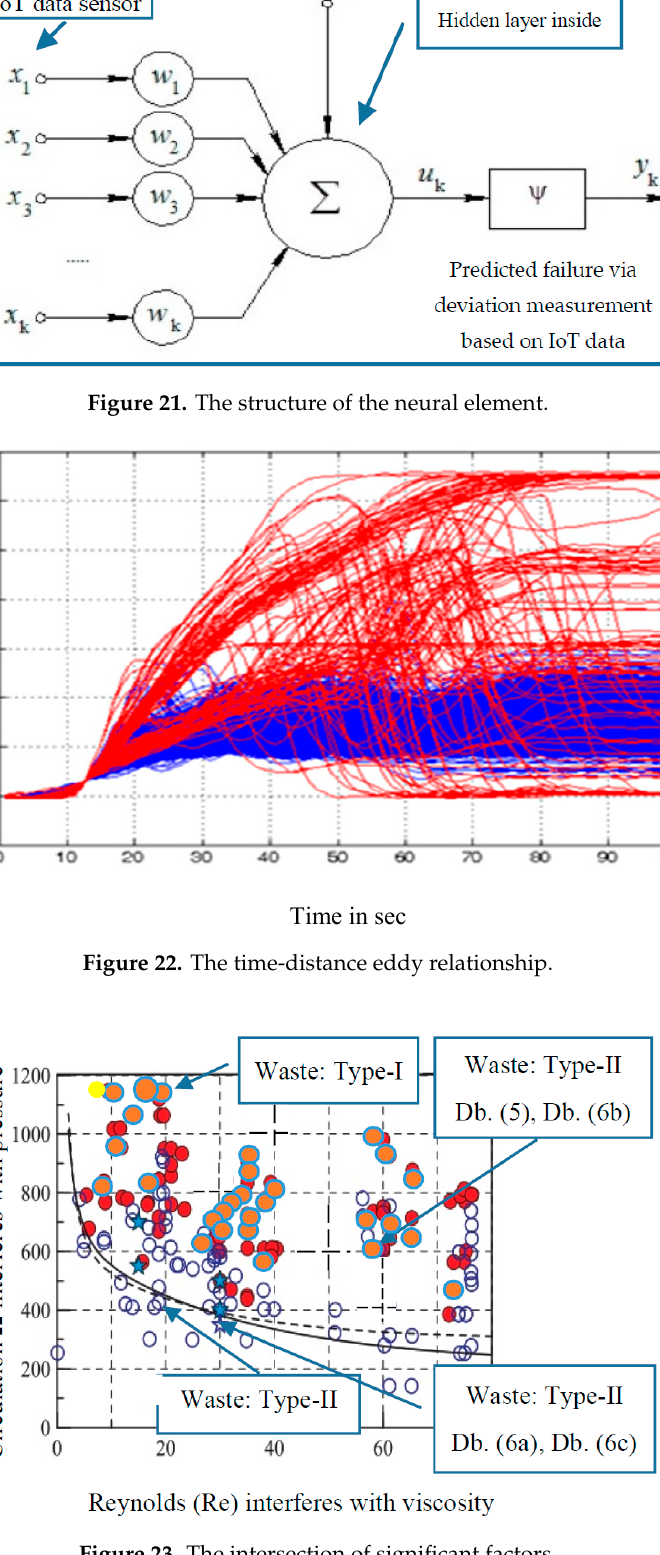
Figure 25. The contour plots of defective causes using beginning values of NN runs. Figure 24. The contour plots of bubble creation causes using beginning values of NN runs.